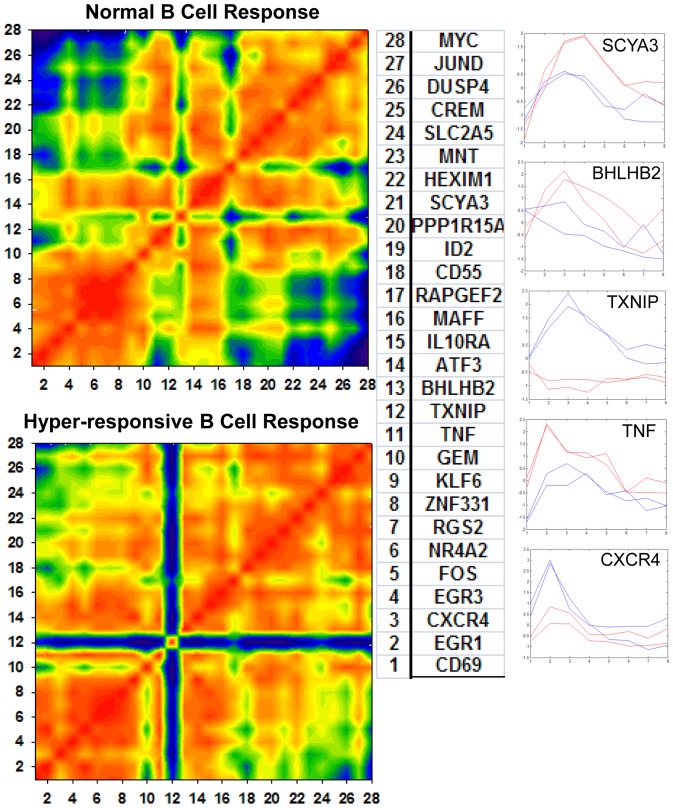
Correlative gene associations in normal B cell responses and in hyperresponsive B cell responses.Pearson correlation was utilized to estimate the correlation coefficients. Negative correlations are shown in blue; while positive correlations are shown in red. Genes examined are listed in table on the left. Gene numbers (right column) are used as coordinates along x and y-axis. Select gene expression graphs are shown on the far right with the two SLE patient cell lines depicted in red and the two control cell lines depicted in blue. The order of genes is maintained giving clear visualization of differences in gene associations.